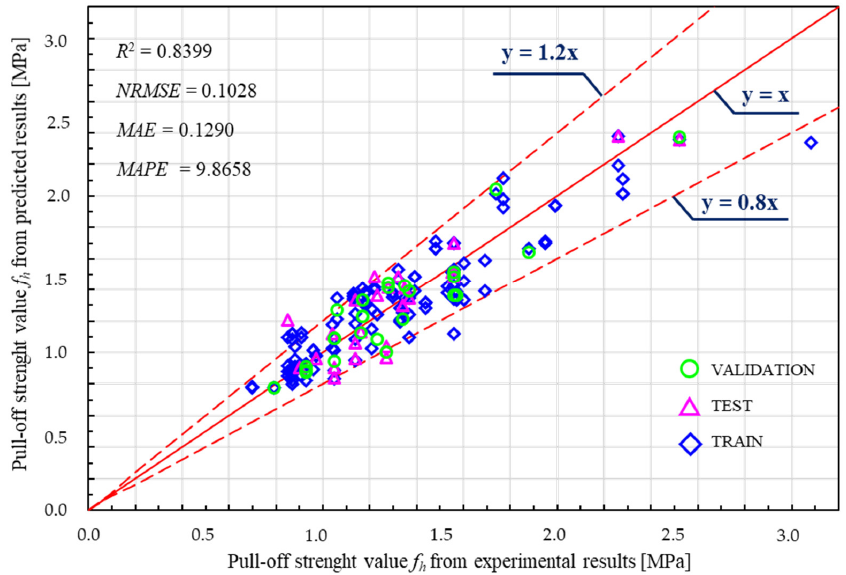
Figure 8. Relationship between the predicted value and the experimental value of the pull-off strength f h for ANN test, train, and validation process for the BFGS algorithm with one layer of hidden neurons.